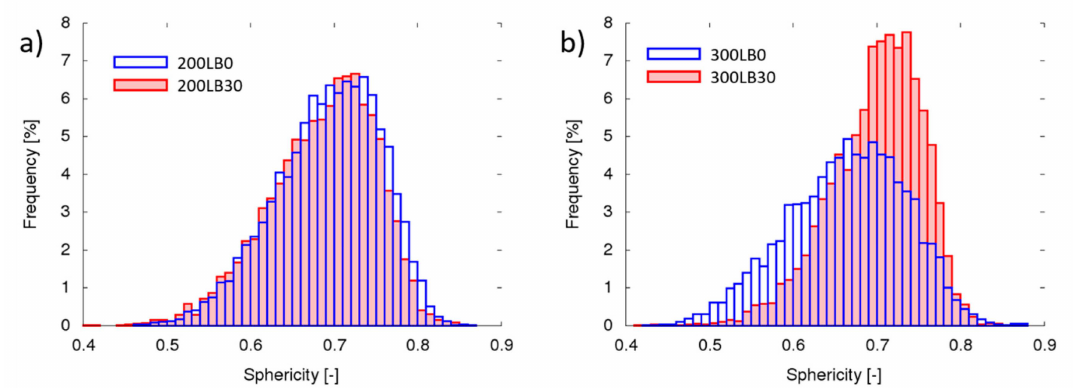
Figure 3. Pore sphericity for samples prepared with: ( a ) I ISO = 200 and ( b ) I ISO = 300.